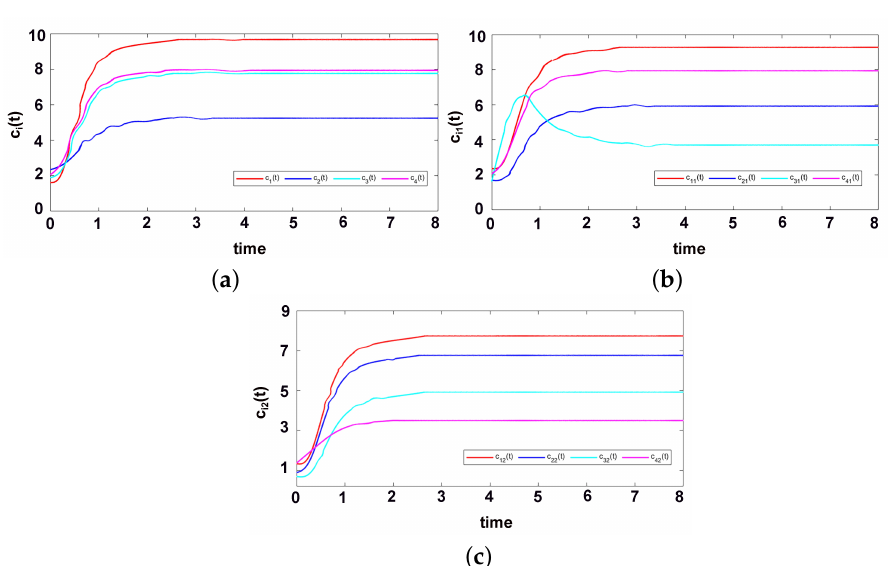
Figure 10. Formation tracking errors in Example 2. ( a ) formation tracking errors of ξ i 1 ; ( b ) formation tracking errors of ξ i 2 ; ( c ) formation tracking errors of ξ i 2 .